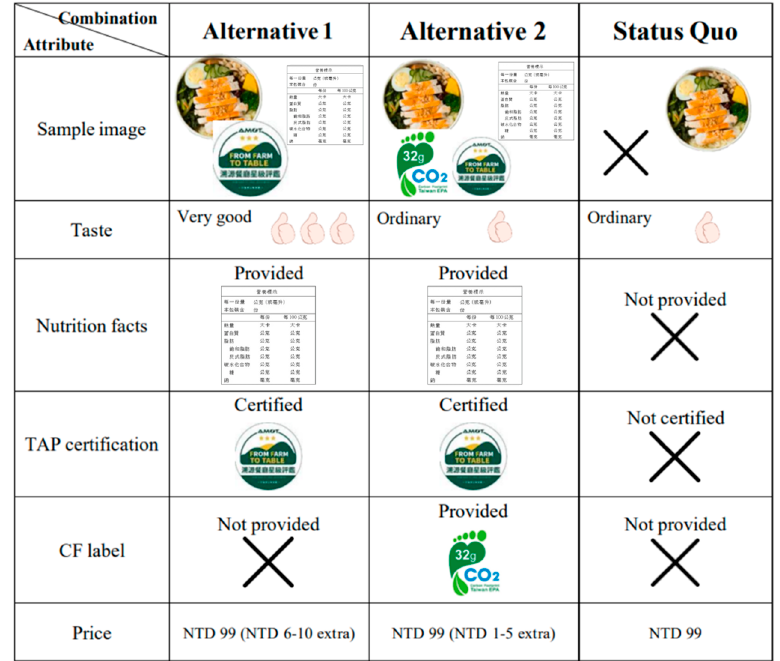
Figure 1. Example questionnaire choice set.